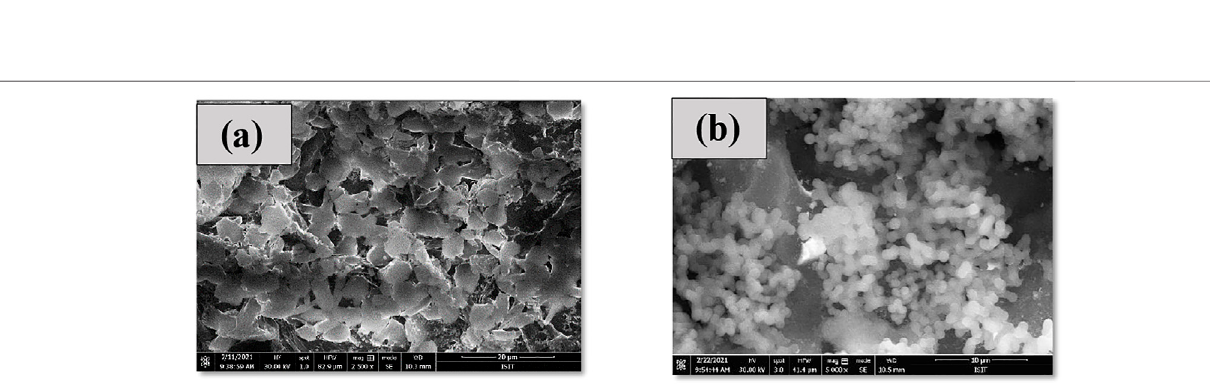
FIGURE 5 | (A) SEM analysis of GO by Hummers method (B) SEM analysis of GO by hydrothermal